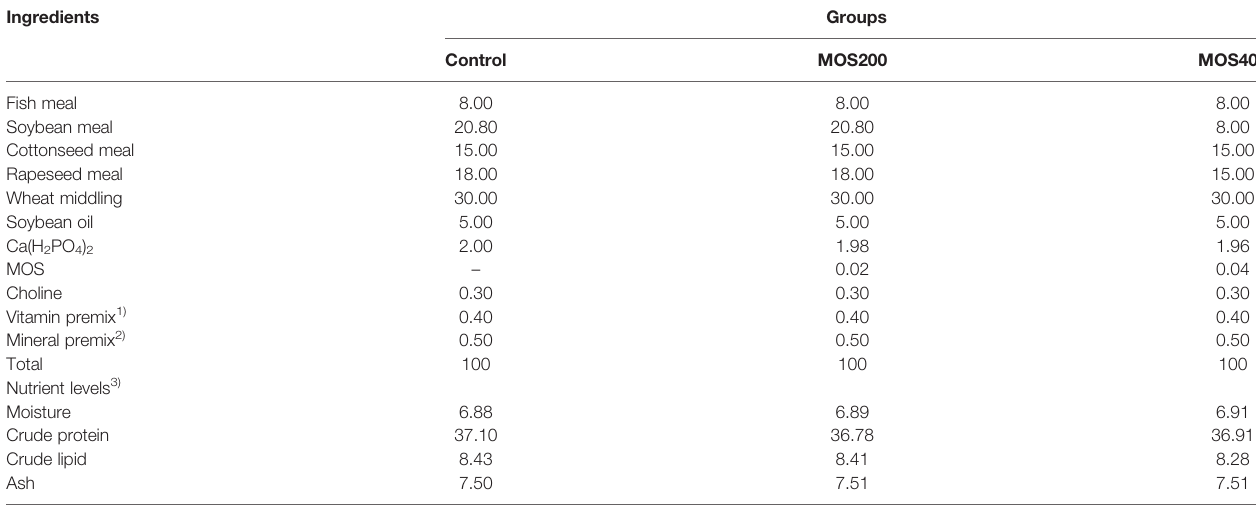
TABLE 1 | Ingredients and nutrient composition of the experimental diets (%).